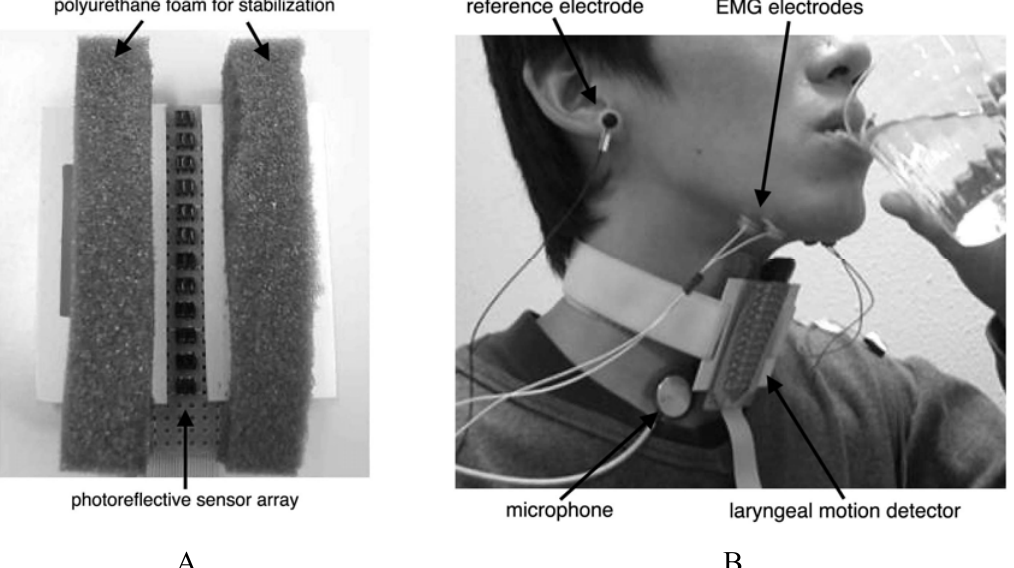
Figure 21. Laryngeal motion detector SFN -2 [63,64] incorporating a photo-reflective sensor. A: sensing surface of the detector. B: various sensors mounted on the anterior region of the